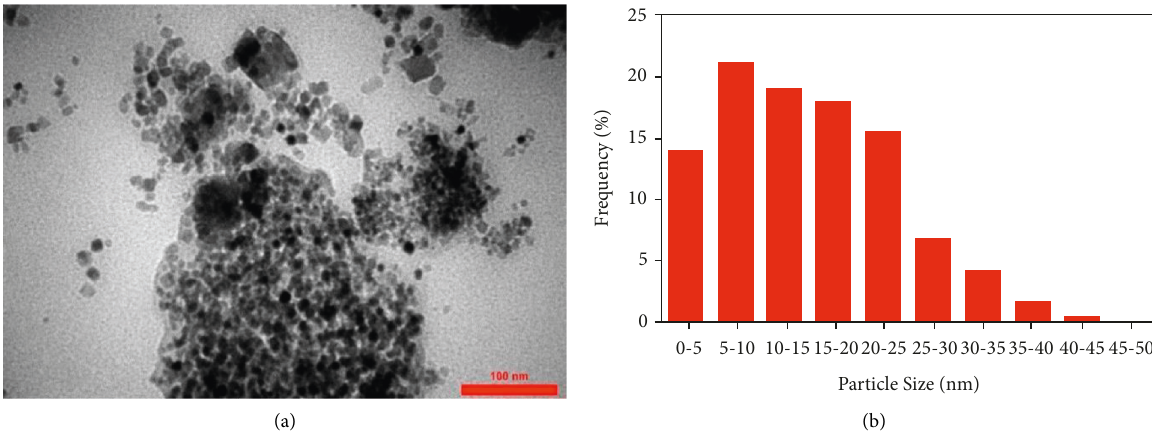
Figure 5: Transmission electron microscope image of selenium NPs (a); particle size distribution analysis of selenium NPs